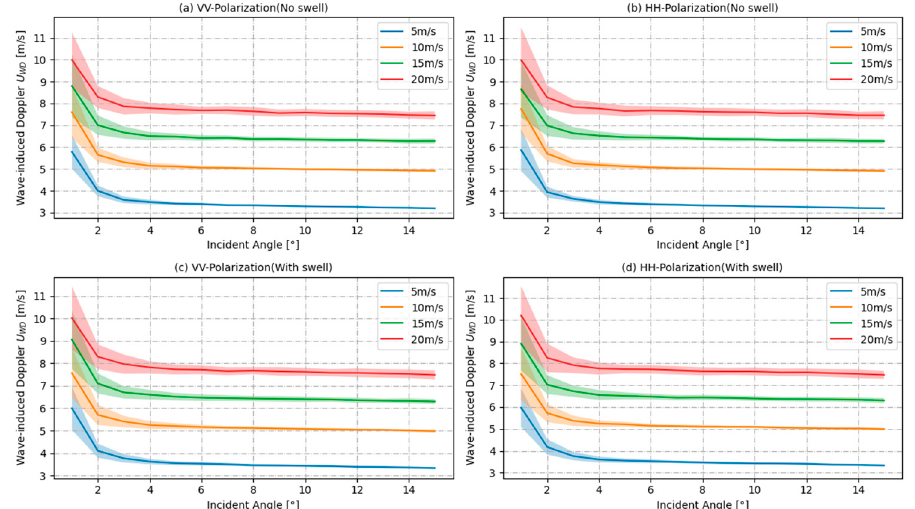
Figure 10. Variation in U WD and standard deviation with radar incidence angle for 5, 10, 15, and 20 m/s wind speeds, with radar azimuth of 0°, wind direction of 0°, there is no swell in ( a , b ), and there is a swell in ( c , d ) with a wavelength of 150 m, a wave height of 1 m, and a direction of 0°. The colored solid lines indicate U WD , and the corresponding colored shading is the standard